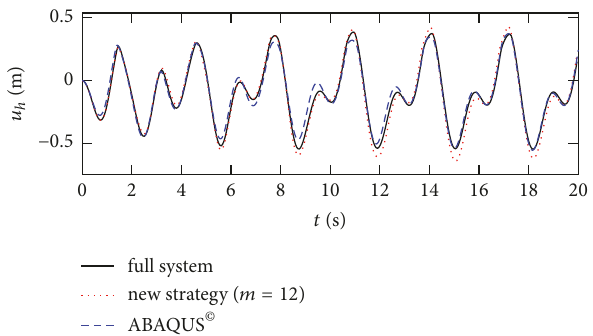
Figure 11: Comparison of the displacement between the in-house software and ABAQUS ©